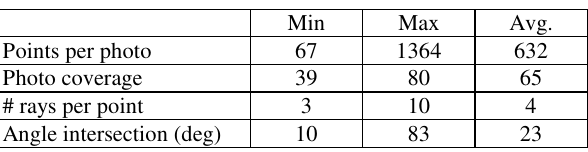
Table 9. Castle: block strength